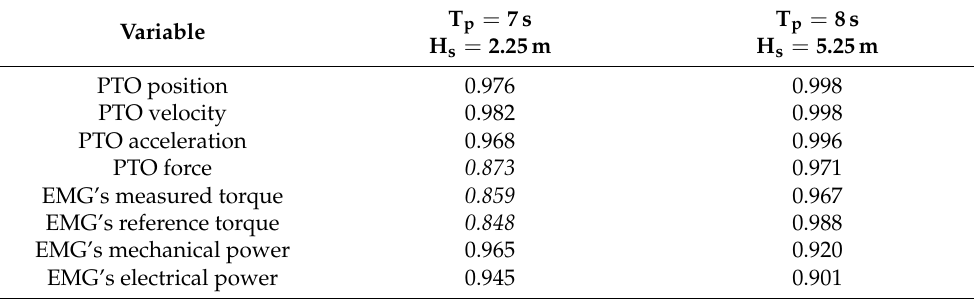
Table 2. NRMSE-based quantitative comparison between offline and real-time